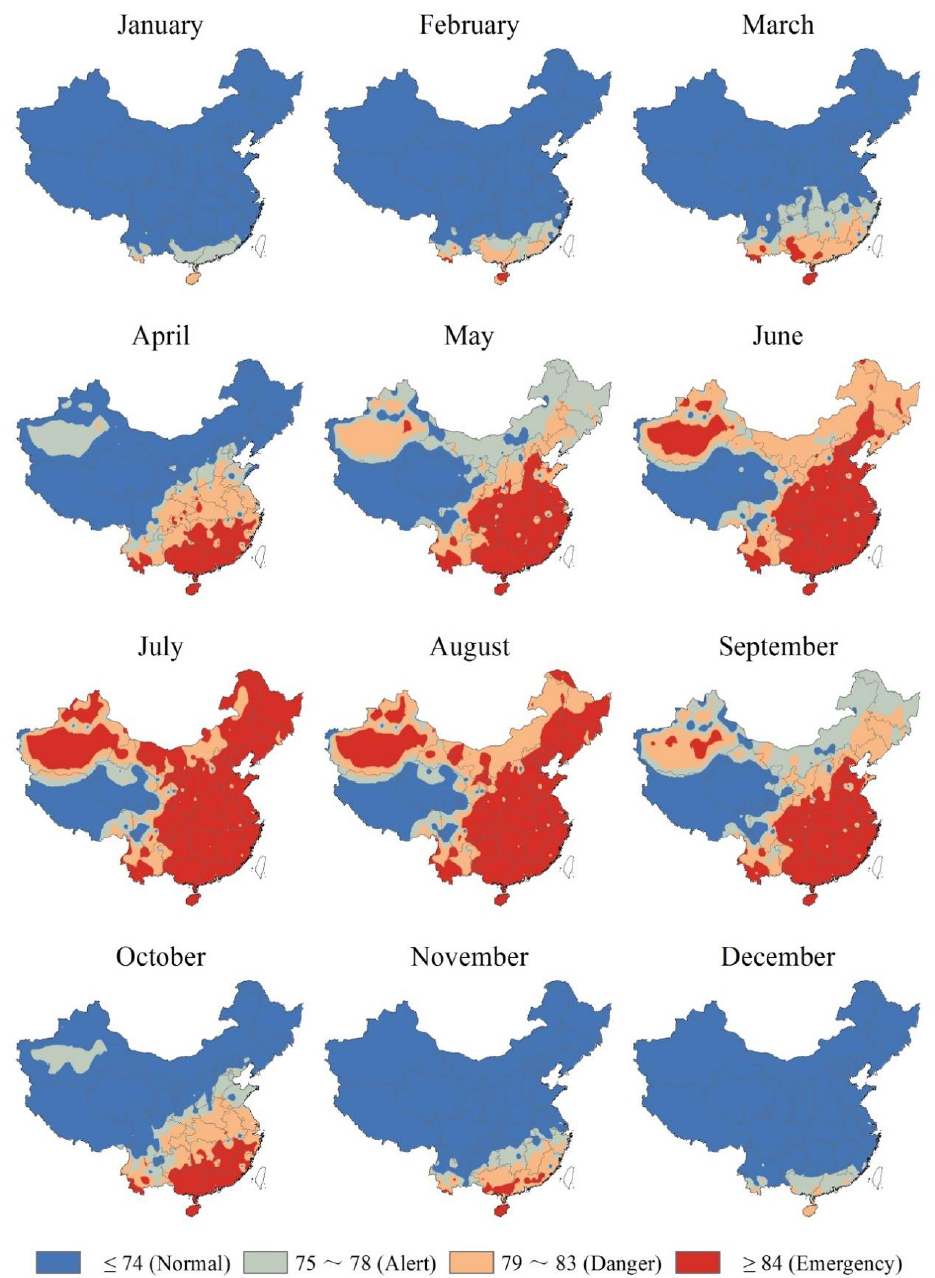
Figure 3. Classified monthly maximum THI maps for January to December.